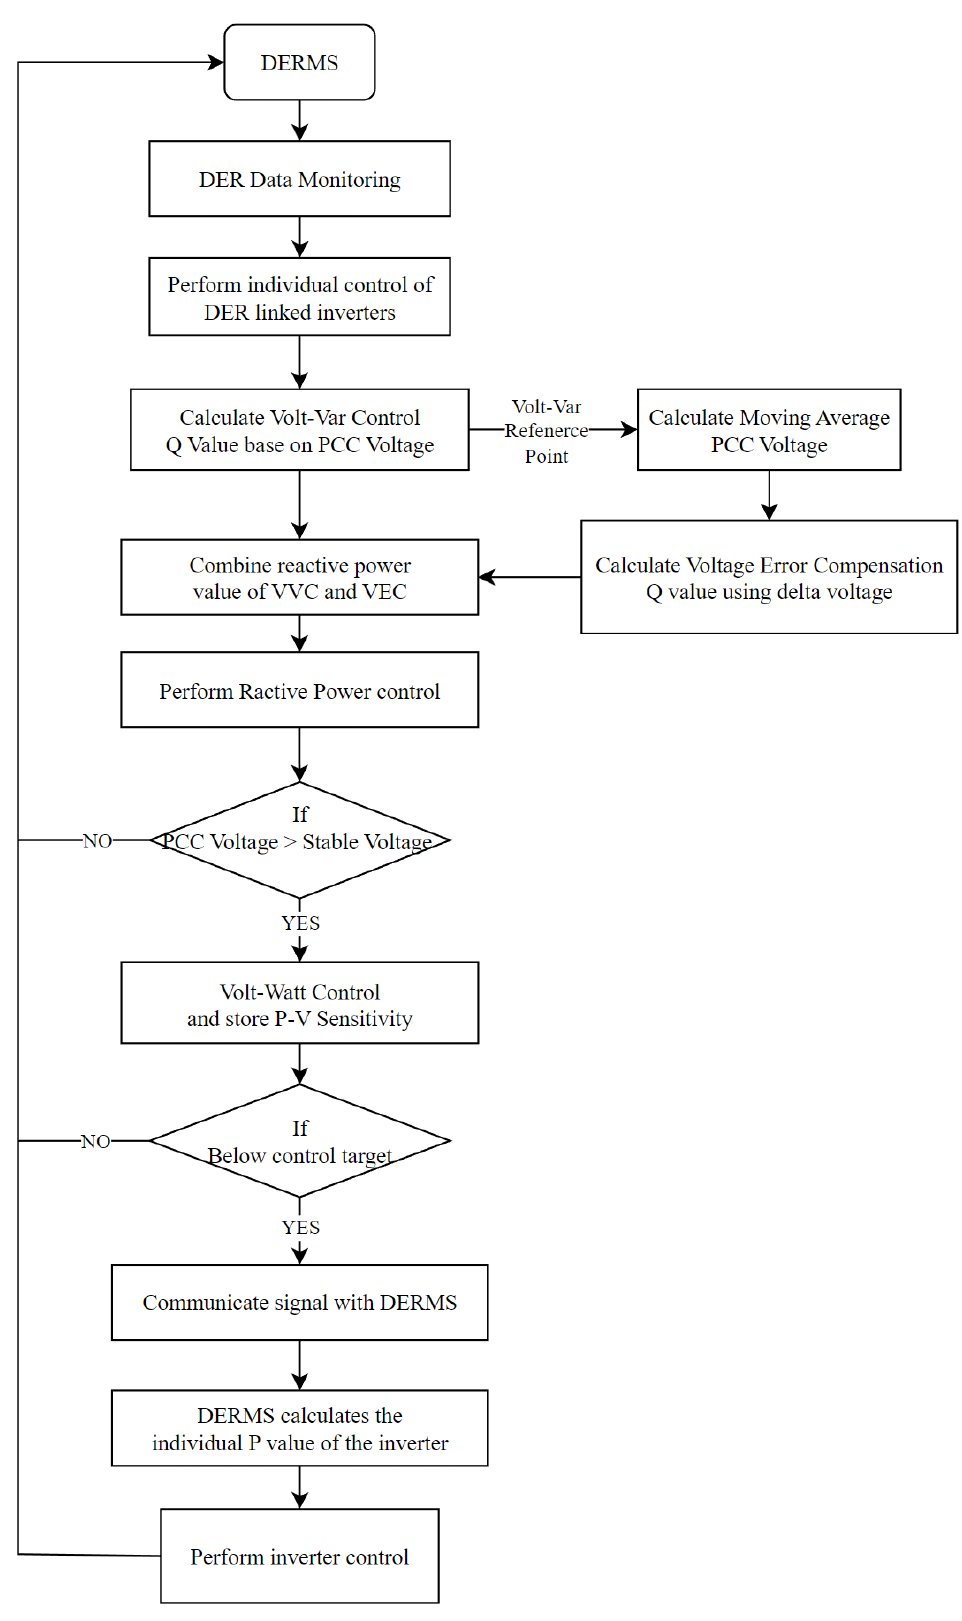
Figure 11. Flow chart illustrating the DERMS process.